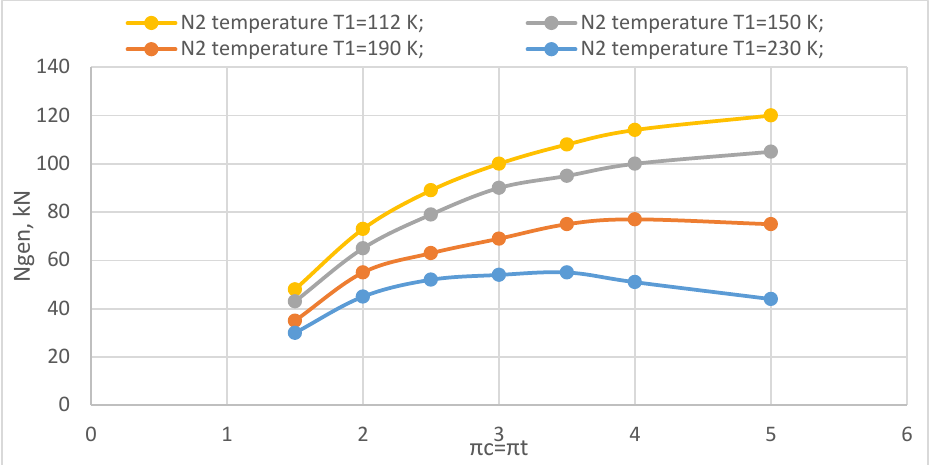
Figure 6. E ff ect of technological system parameter π C = π T on N gen .